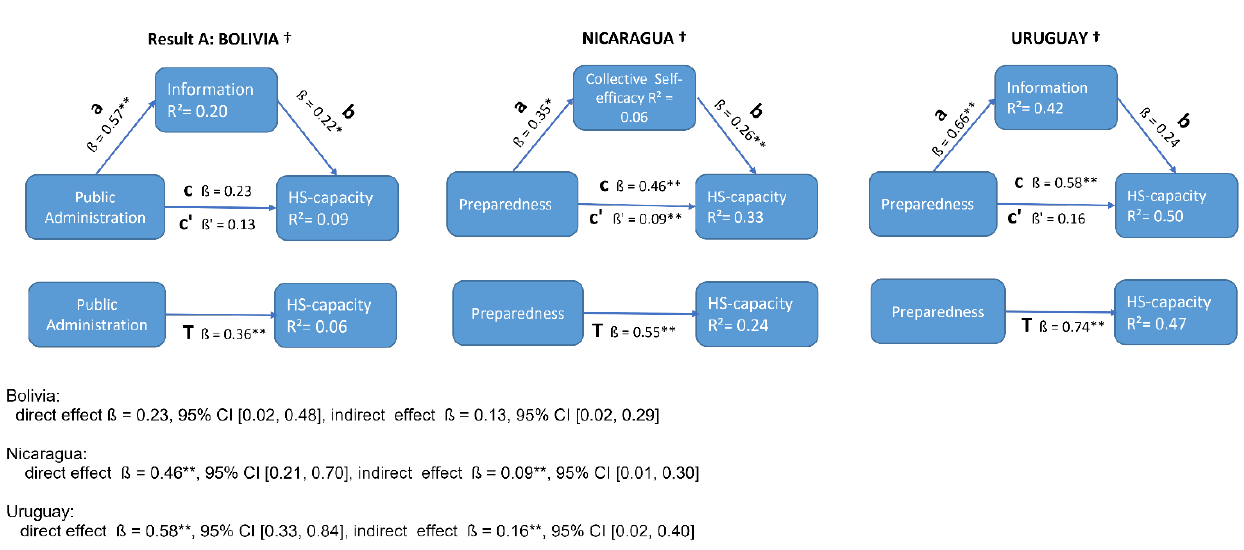
Figure 5. The mediating effect of information and collective self- efficacy. Details: ab = mediation effect; c = direct effect; c’ = indirect effect; T = total effect. The number of bootstrap samples was 5000. ß = direct effect and ß ’ = indirect effect. † * p < 0.05, ** p < 0.01.